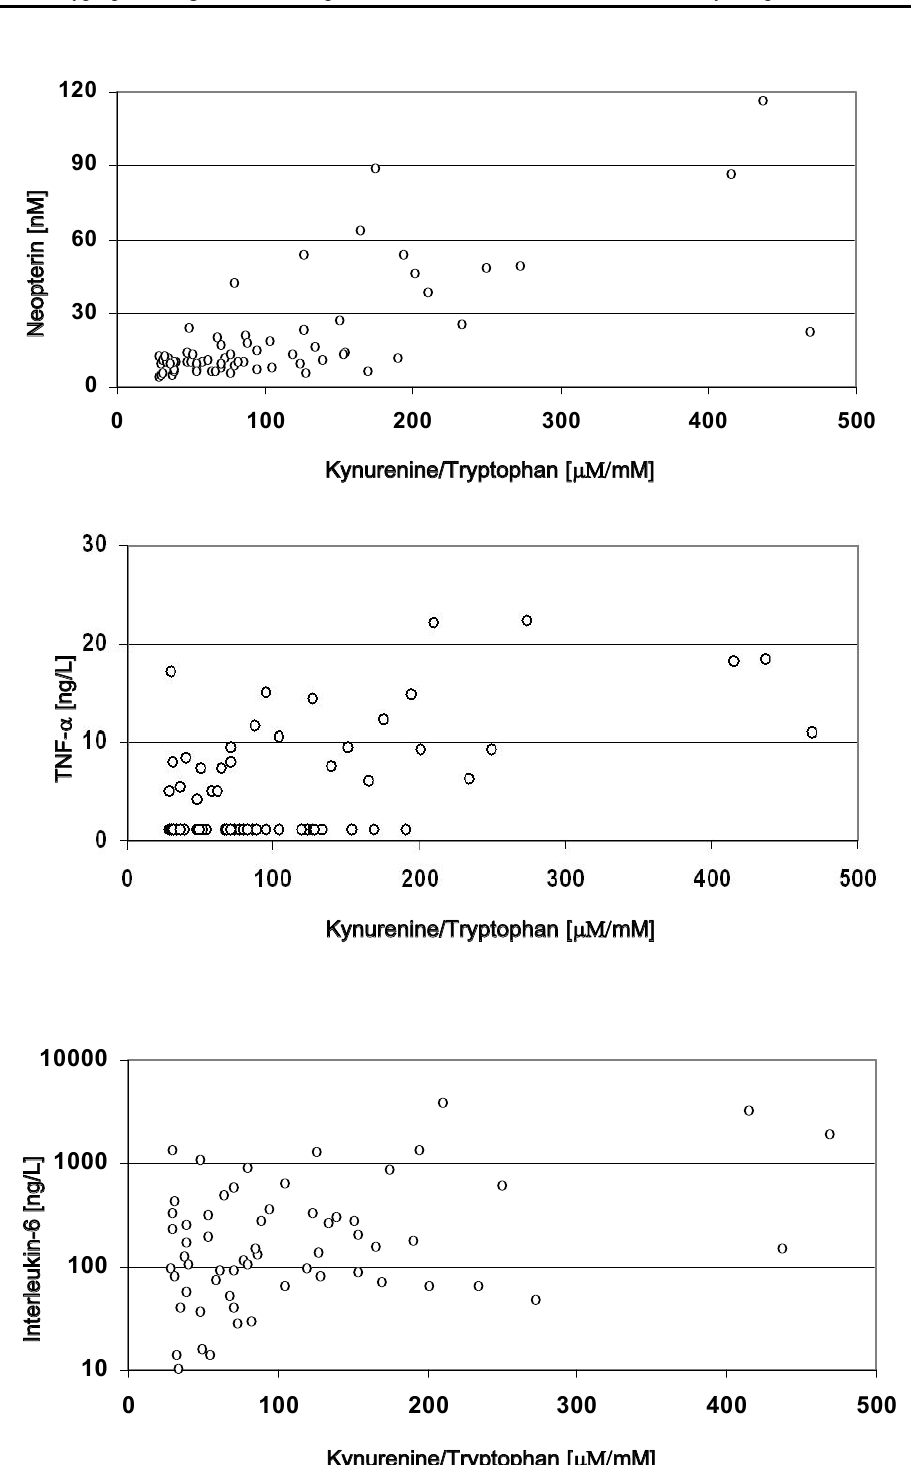
Fig. 3 Correlations between kynurenine to tryptophan ratio and serum neopterin (rs = 0.590, p <0.001; upper), = 0.374, p < 0.01; middle) and interleukin-6 concentrations (r = 0.262, tumor necrosis factor- α (TNF- α ; r s s p < 0.05; lower) in patients post trauma during follow-up for 2 found to strongly predict shortened survival (25-27). Also in patients with HIV-1 infection, antimicro- bial/antiviral activity of IDO is suggested to contribute